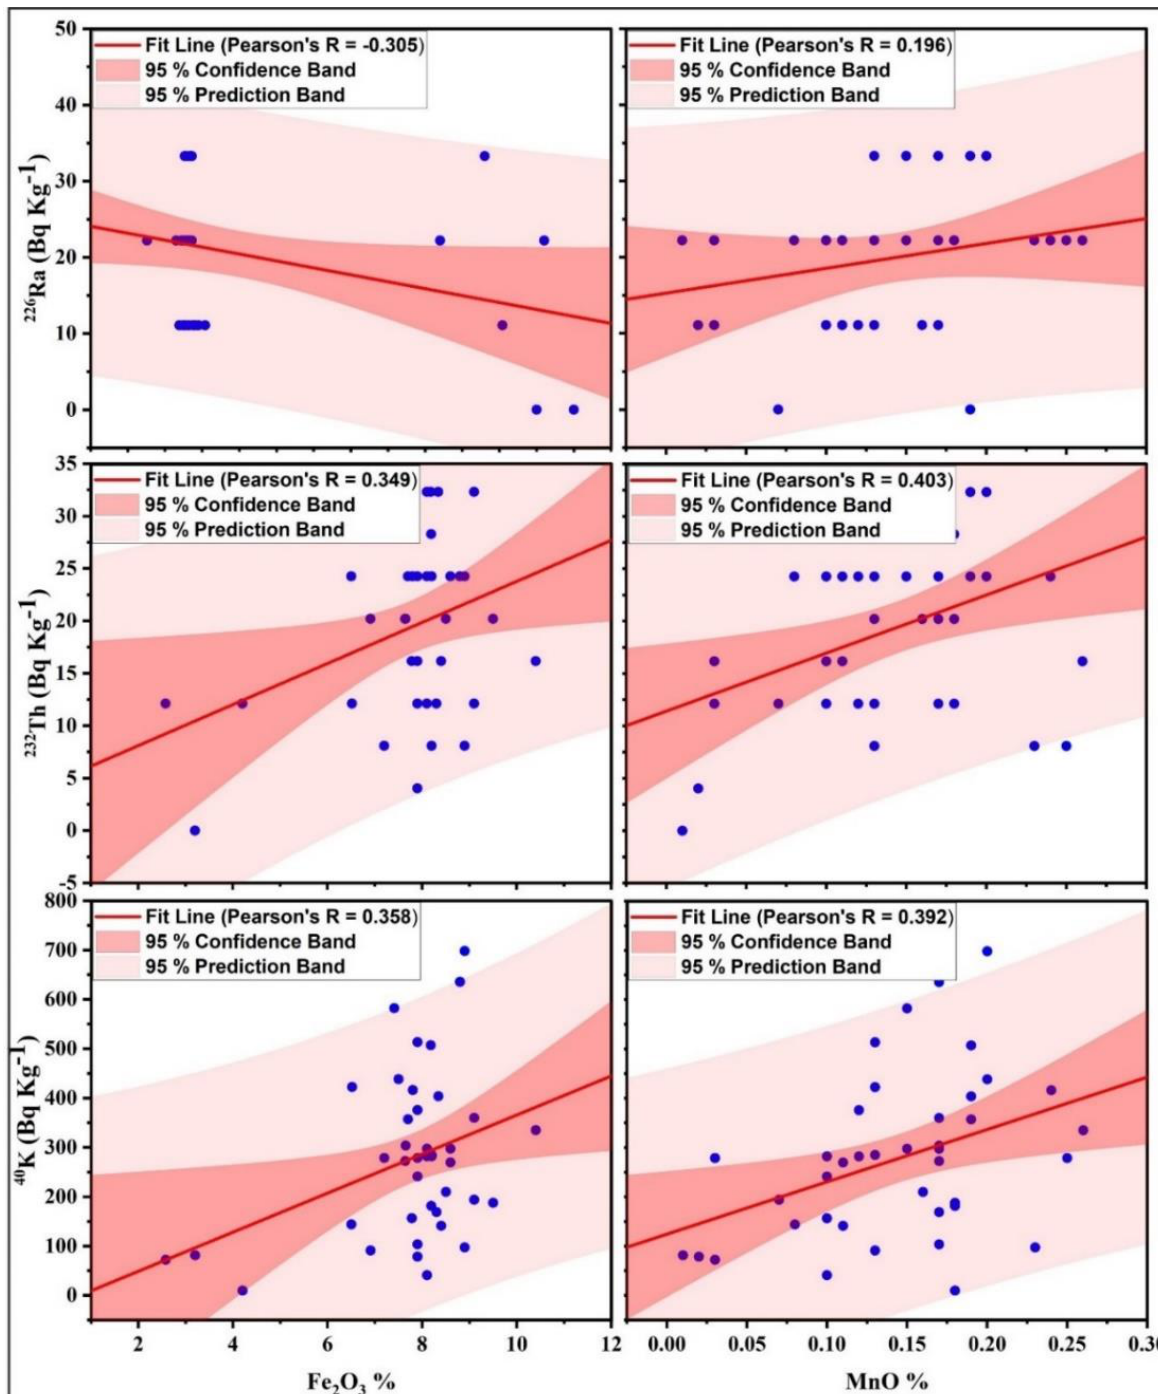
Figure 7. Scatter plots showing the relationships between 226 Ra, 232 Th, and 40 K, and Fe and Mn oxides %.